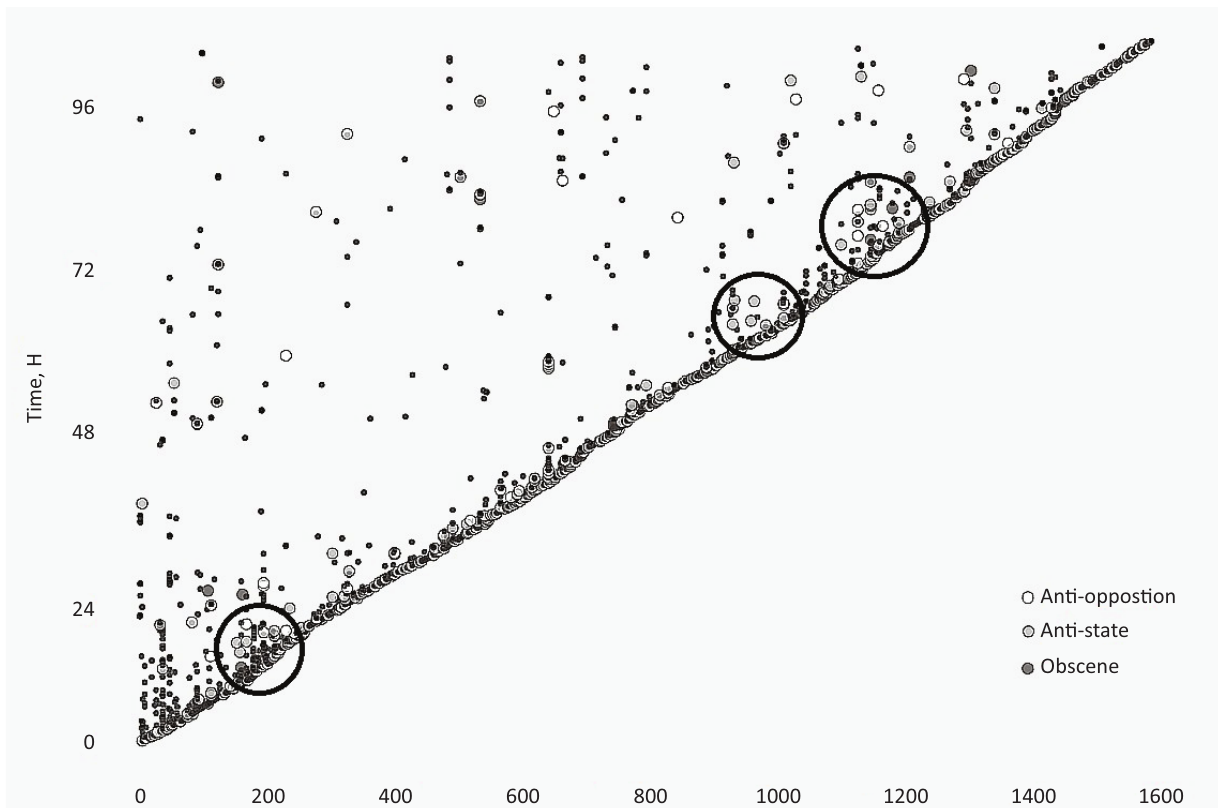
Figure 4. Linear histogram, video 13: Micro-clusters of